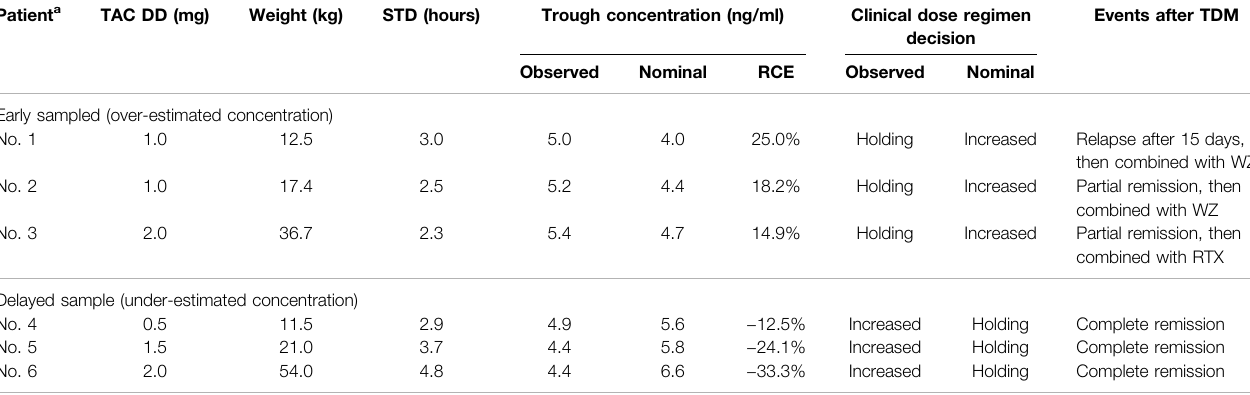
Events after TDM decision Observed Nominal RCE Observed Nominal